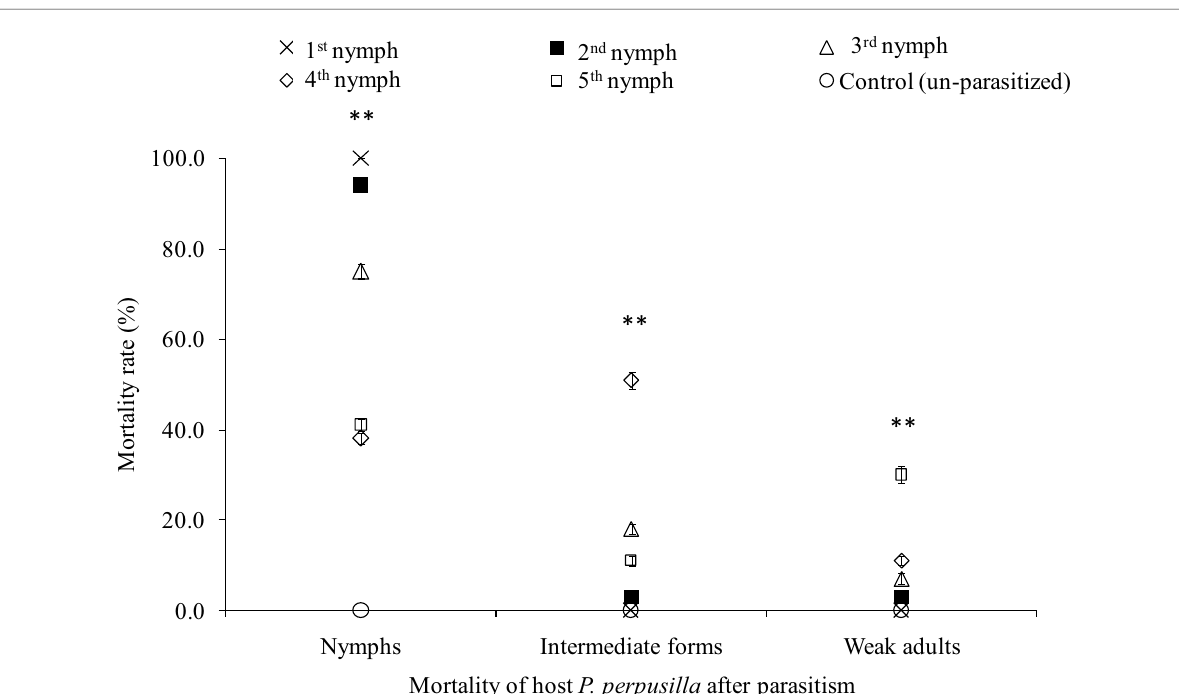
The longevity of parasitized males was significantly longer ( 7.15 days) than the un-parasitized males. Simi- + larly, parasitized females survived for a longer period ( 5.26 days) as against un-parasitized ones (Table 2). +